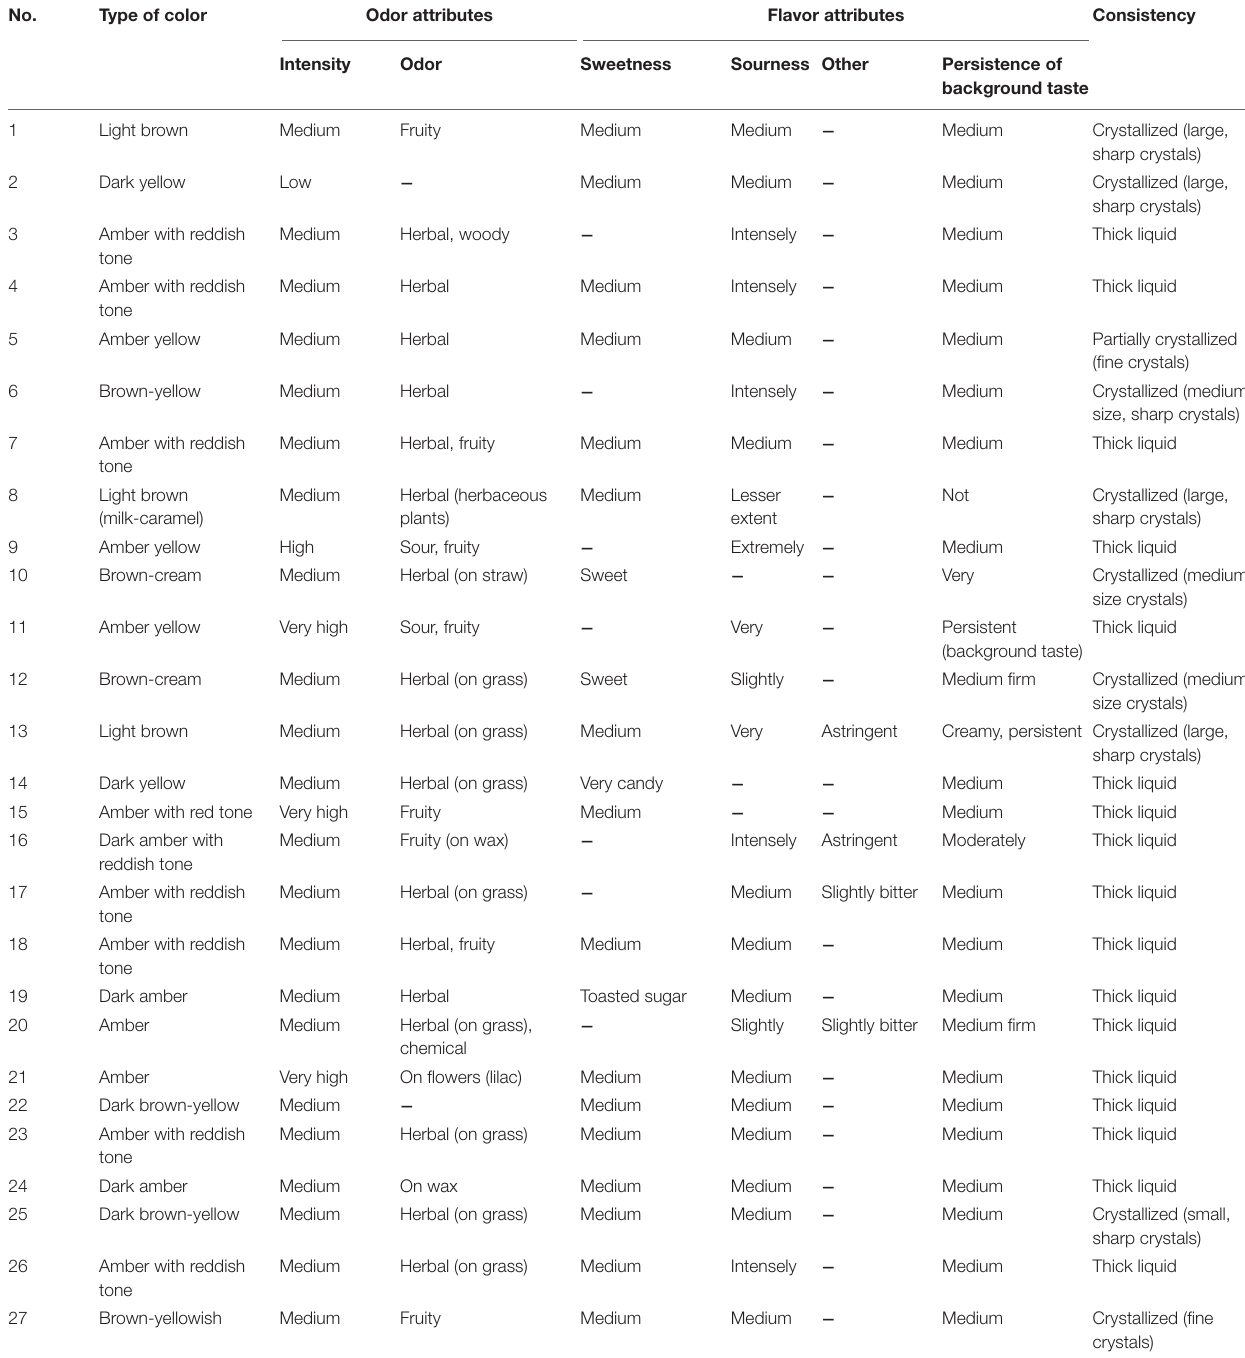
TABLE 2 | Sensory analyses of 27 honey samples from the Tara Mountain region in Serbia.